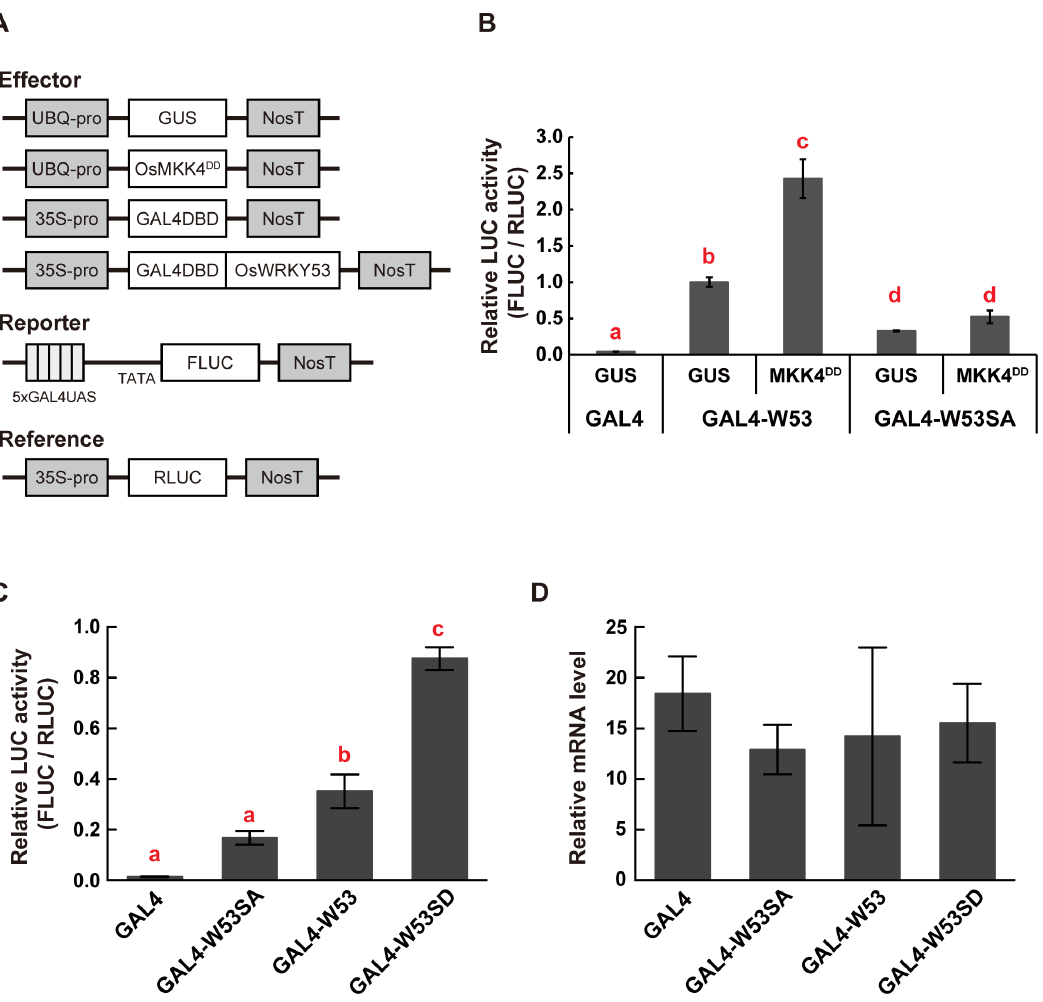
Figure 3. Post-translational regulation of OsWRKY53 transactivation activity by OsMKK4 DD . A , Diagrams of effector, reporter, and reference plasmids used in transient reporter gene assays. B , Regulation of transactivation activity of OsWRKY53 by OsMKK4 DD in cultured rice cells. A GUS construct was used as a negative control. Firefly LUC activity was normalized against that of Renilla LUC. Values of LUC activity are shown relative to those of GAL4-W53 + GUS (n=4); bars indicate the standard error of the mean. Three independent experiments were performed, and a representative result is shown. Statistically different data groups are indicated using different letters ( p , 0.01 by One-way ANOVA with Tukey post hoc test). C , Enhanced transactivation of a phosphorylation-mimic mutant of OsWRKY53 in cultured rice cells. Transient reporter gene assay was performed as in B . Values of LUC activity are shown relative to those of GAL4-W53 (n=4); bars indicate the standard error of the mean. Three independent experiments were performed, and a representative result is shown. Statistically different data groups are indicated using different letters ( p , 0.05 by One-way ANOVA with Tukey post hoc test). D , Expression analysis of GAL4DB and GAL4DB-OsWRKY53 variants in cultured rice cells. qRT- PCR analysis was performed using total RNA isolated from rice cells after particle bombardment with effector, reporter and reference plasmids. Values indicate relative mRNA levels normalized to the expression of the RLUC gene (n=4); bars indicate the standard error of the mean. W53, W53SA and W53SD indicate the native OsWRKY53, an OsWRKY53 mutants whose Ser residues in the SP cluster were substituted to Ala, and an OsWRKY53 mutant that mimics the phosphorylated form, respectively.